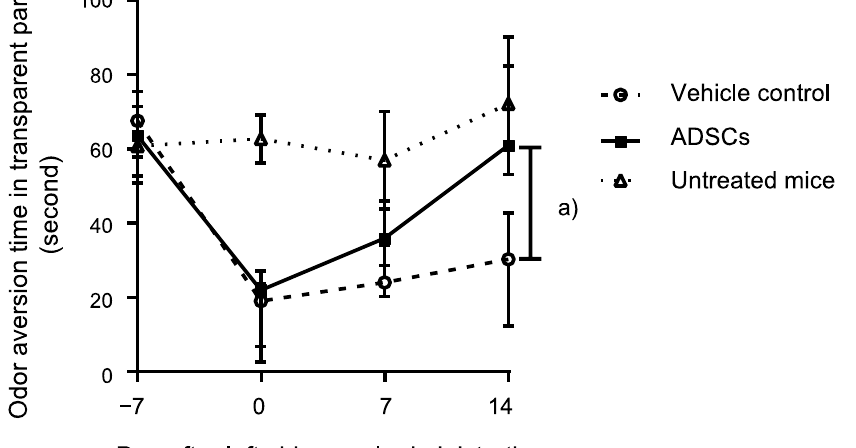
Figure 1. Odor aversion behavior analysis of mice treated with murine adipose-derived stem cells (ADSCs). Comparison of odor aversion behavior to butyric acid determined with located time in the transparent part of the box over 3 min of observation between ADSC- and PBS-treated olfactory- impaired mice on day 14. The points with bars indicate medians with interquartile range. The untreated mice were also assessed with odor aversion behavior to butyric acid. Statistical significance was determined by the Mann–Whitney test. a) p = 0.002.